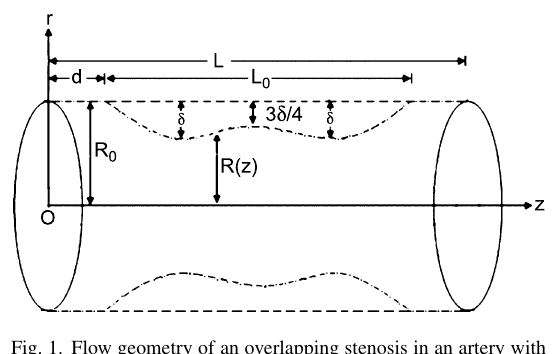
Fig. 1. Flow geometry of an overlapping stenosis in an artery with permeable wall. as a single-phase homogeneous viscous fluid while flowing through narrow arteries (of diameter ≤ 1000 (cid:1) m ). Srivastava and Srivastava [38] observed that the individuality of red cells (of diameter 8 (cid:1) m ) is